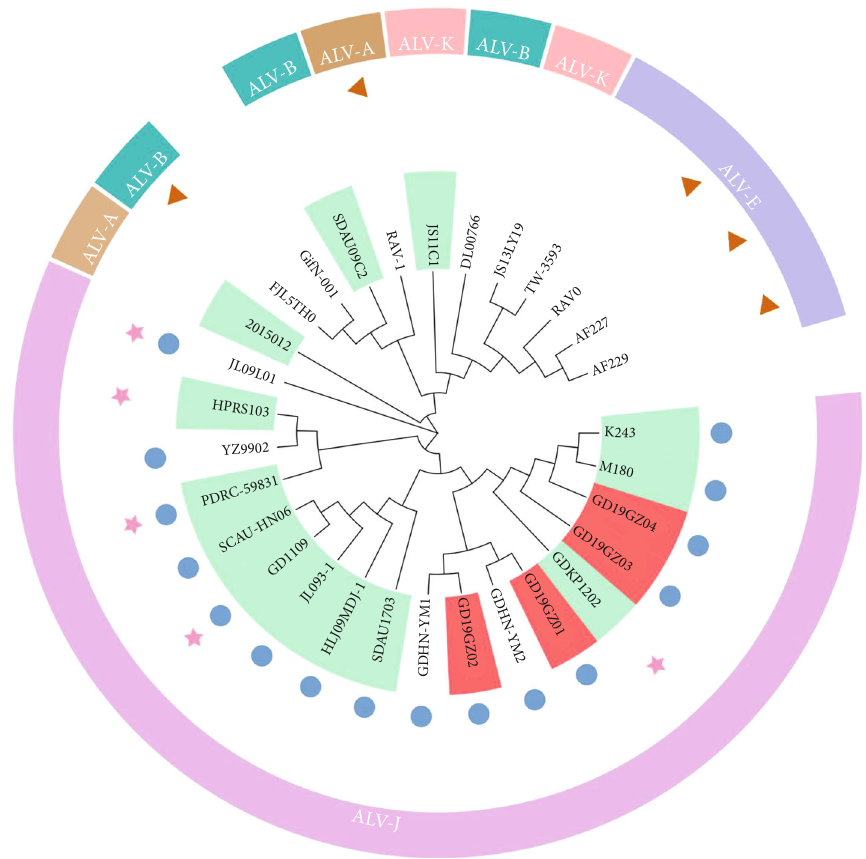
Figure 4: Phylogenetic relationships of the four isolates to the reference strains, based on the proviral genome sequence. The red background indicates the four isolates and the green background indicates the reference strains that retained the E element. The blue circle indicates hemangioma (He), pink stars indicate myeloma (ML), brown triangles indicate lymphoma leukosis